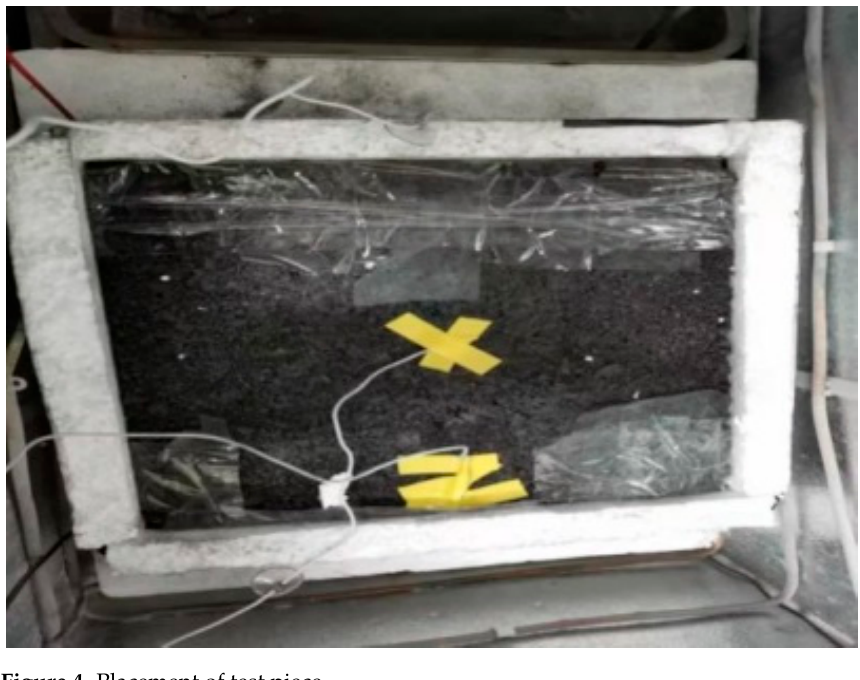
Figure 4. Placement of test piece.